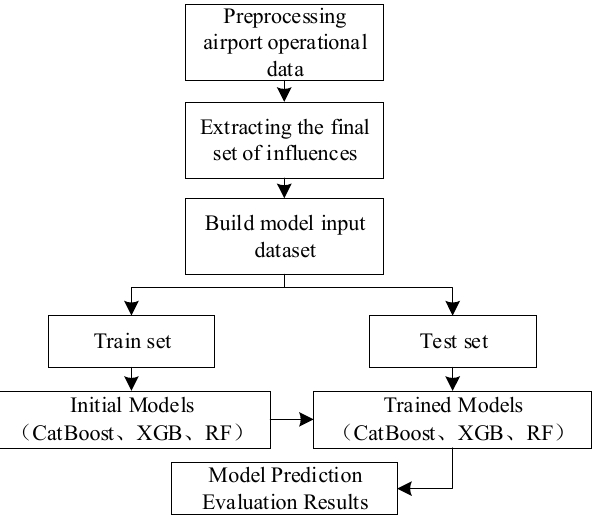
Figure 5. Methods and steps for duration prediction.